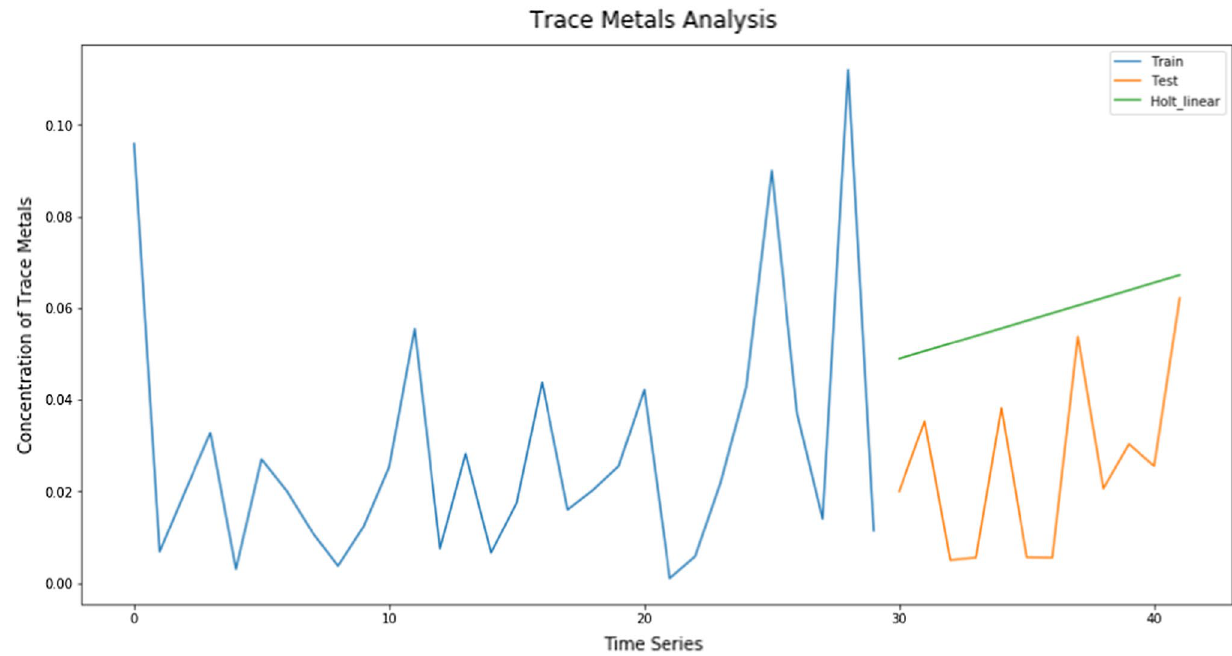
Fig. 9 Trace metals prediction using Holt linear (machine learning with